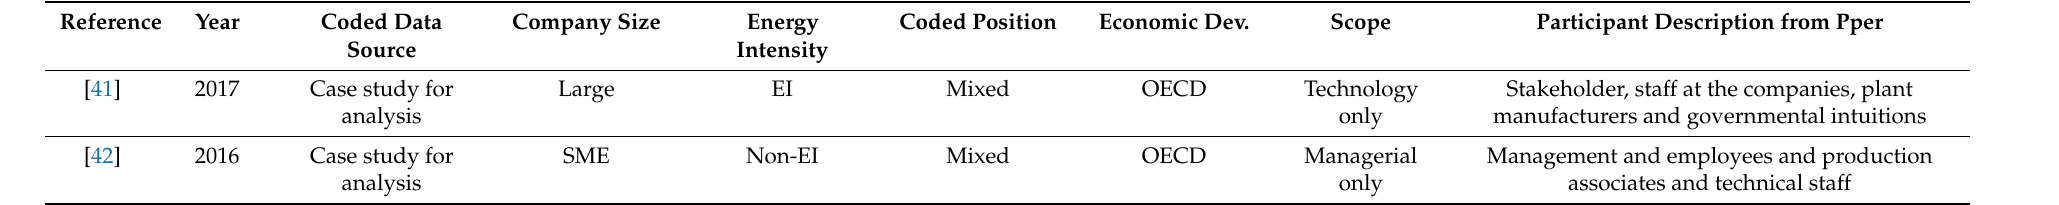
Table A2. Systematic literature review data and coding for papers not using survey and/or interview as a data